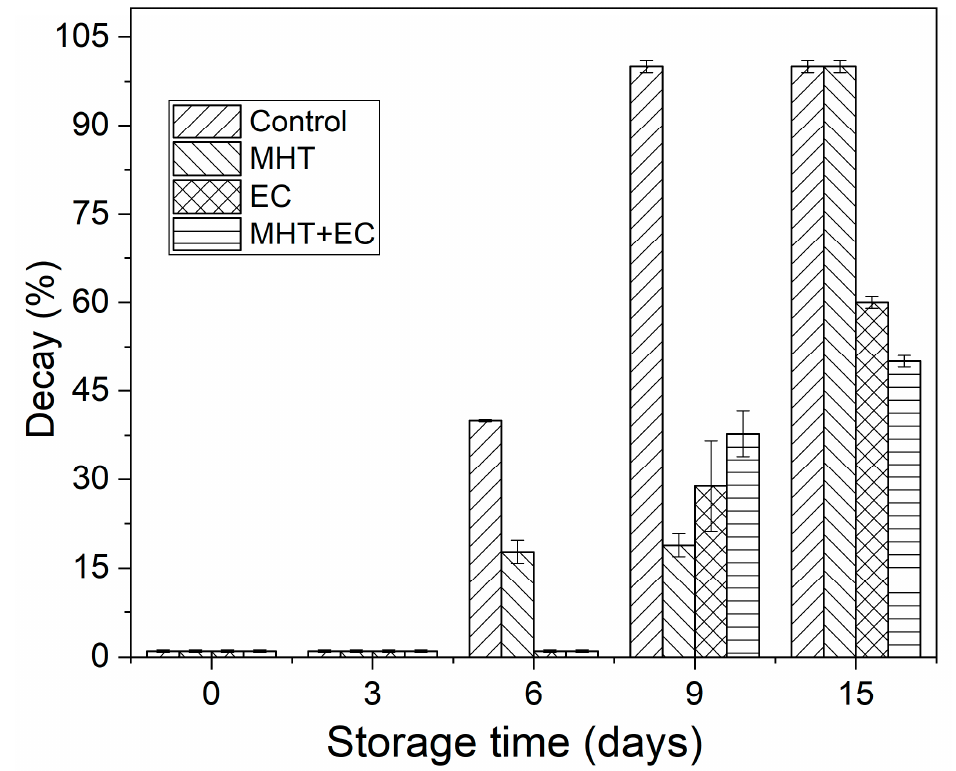
Figure 8. Incidence of decay in control and treated minimally processed bunching green onion during storage.